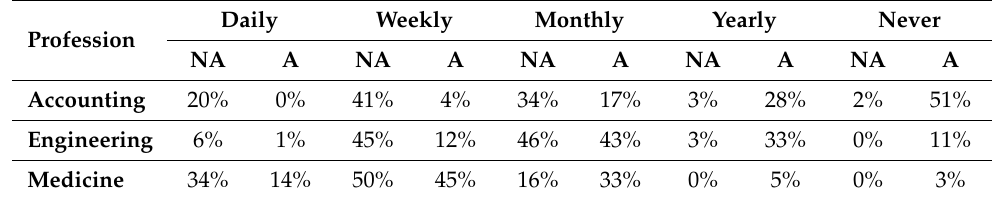
Table 4. Practitioners’ reading of professional material: Non-Academic (NA) vs. Academic (A). Daily Profession